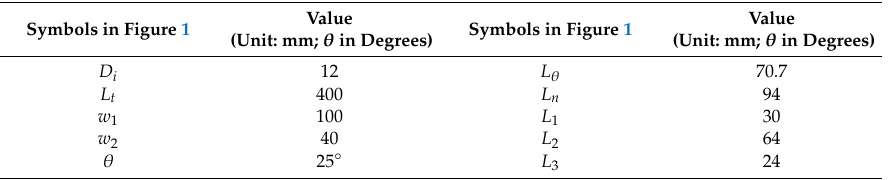
Table 1. Dimensions of di ff user